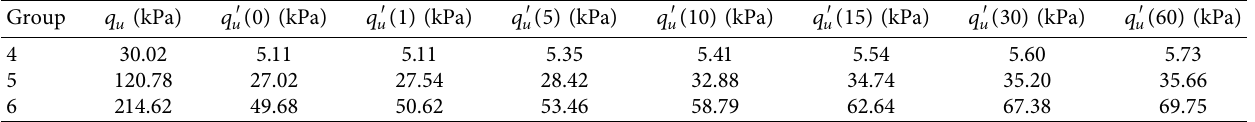
Table 9: Unconfined compressive strength test results of samples at different curing times.